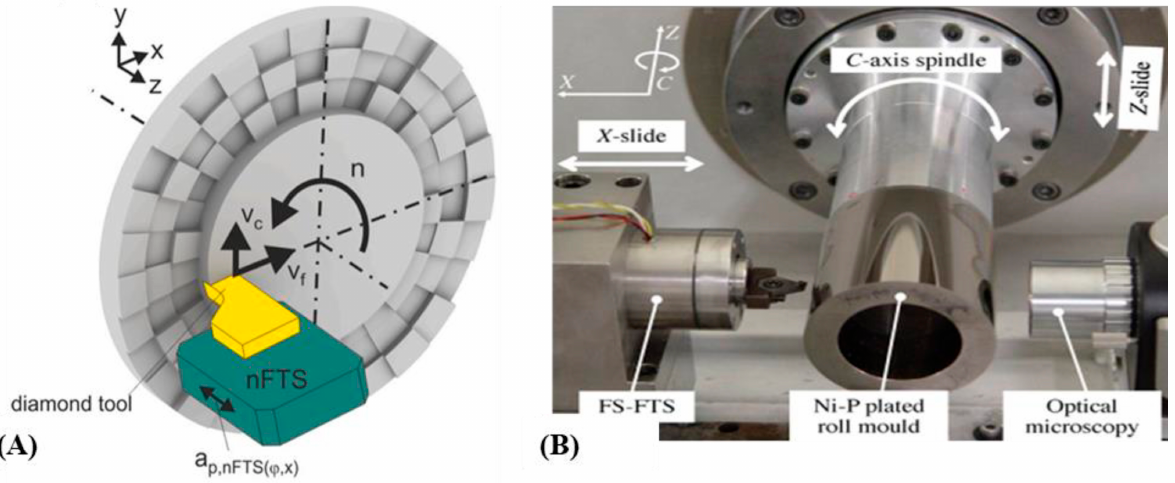
Figure 2. Fast tool servo examples. ( A ) Process schematic of FTS machining during SPDT [31]; ( B ) A FTS machine setup for machining on a roll mold [32]. For Figure 2B, readers should take note that the spindle rotation should ideally not be referred to as the C-axis if the cutting motion is provided by its rotation. Spindle rotation can be termed as C-axis if it performs indexing motion such as those in mill turn machining